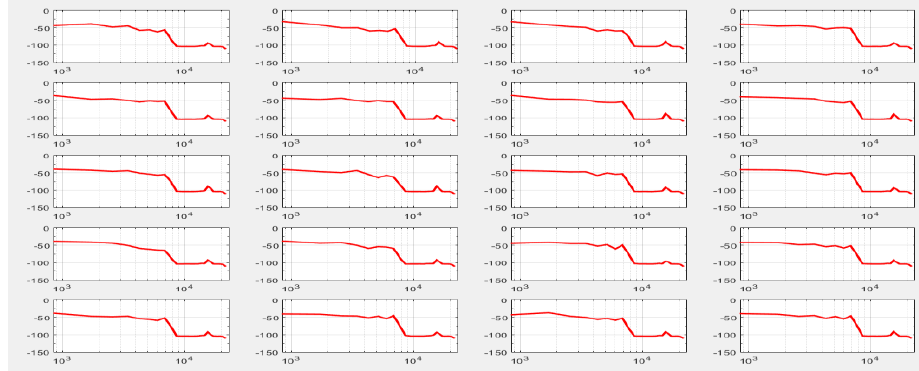
Fig. 2 Averaged spectrum of typical speech messages of phraseological radio exchange in